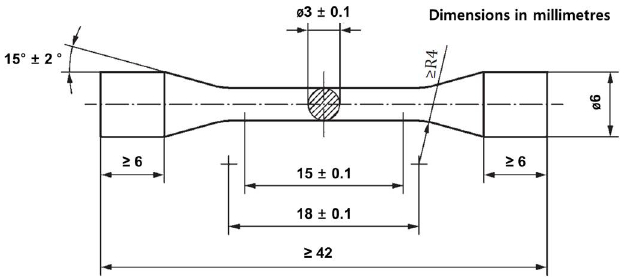
Figure 2. Dumbbell-shaped test specimens manufactured according to schematic drawing of ISO 22674. The composition of alloys by group is shown in Table